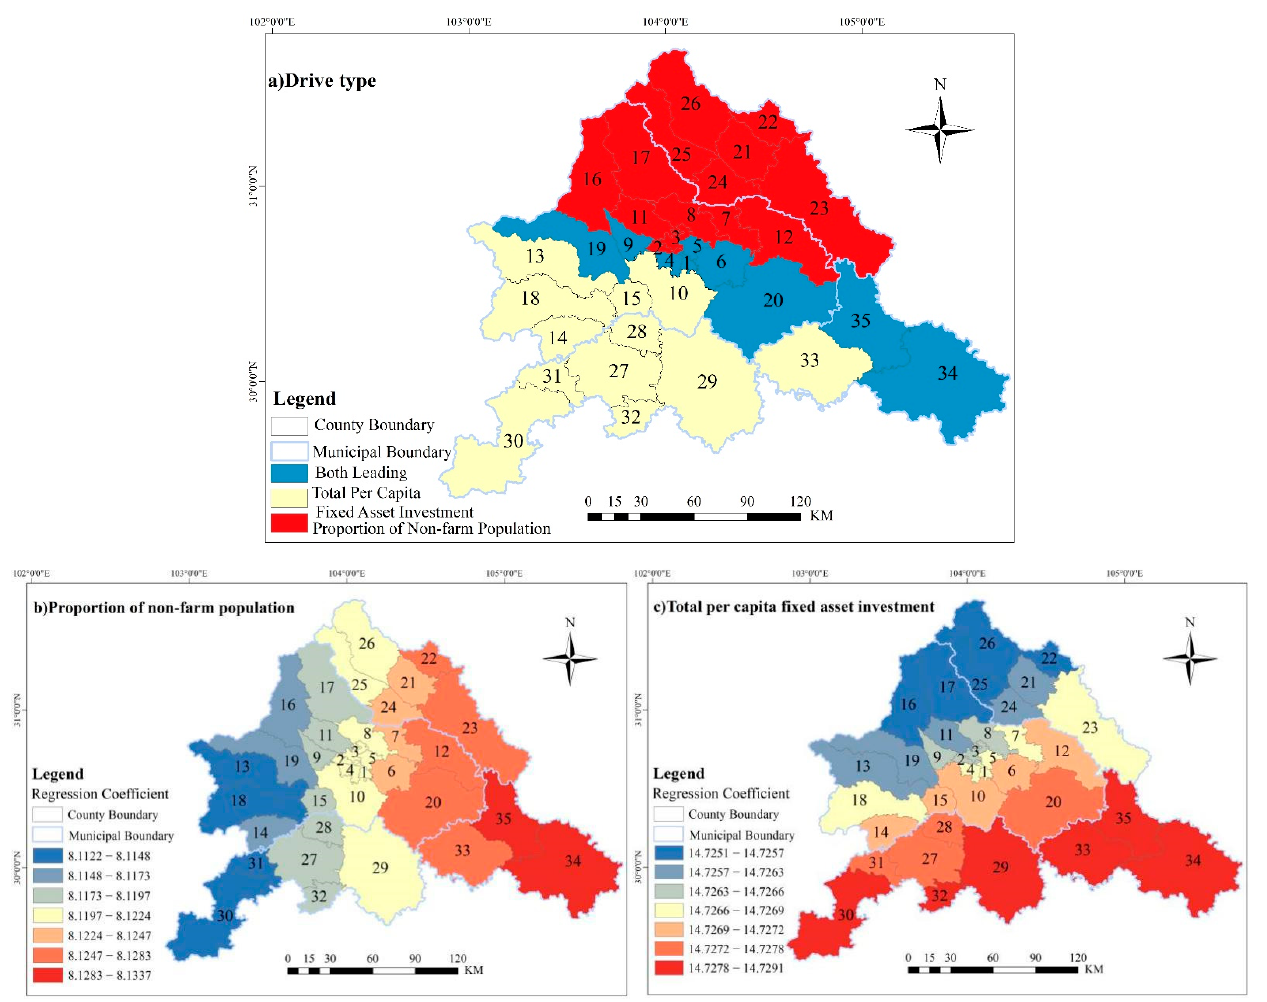
Figure 5. Dominant factors and driver types from 2005 to 2010: ( a ) Distribution pattern of dominant driver types; ( b ) Regression coefficient of the proportion of the non-farm population; ( c ) Regression coefficient of per capita fixed asset investment.